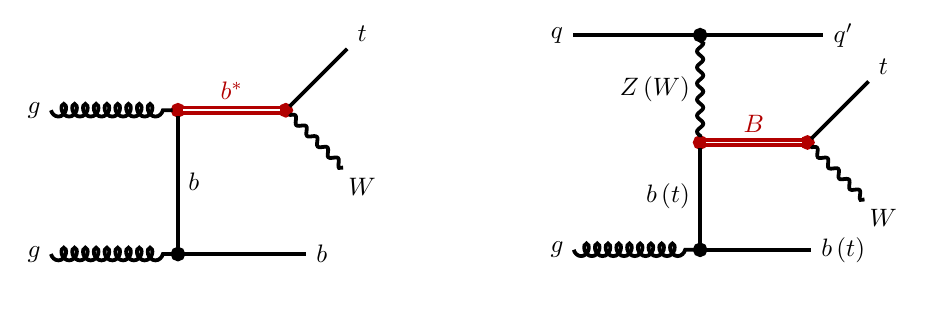
Figure 1 . Example Feynman diagrams at LO of the production and decay of a b ∗ (left) and a B quark (right), drawn with the TikZ-Feynman package